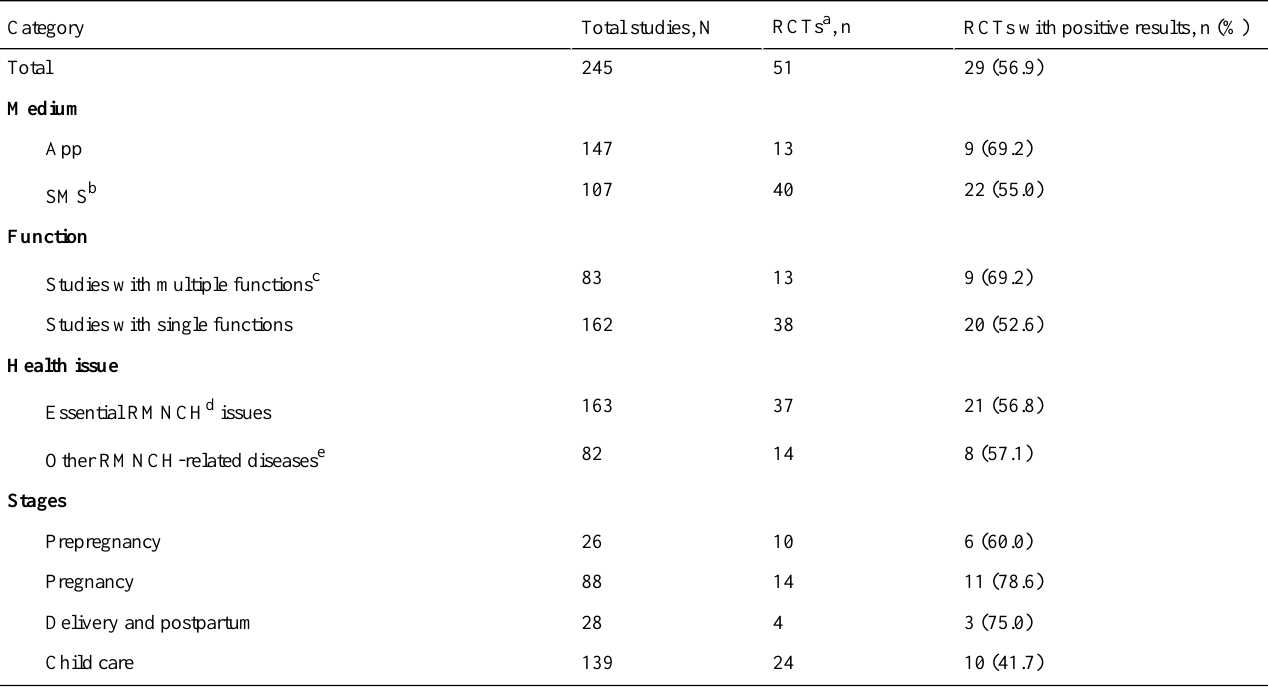
Table 3. mHealth interventions and results from randomized clinical trials.